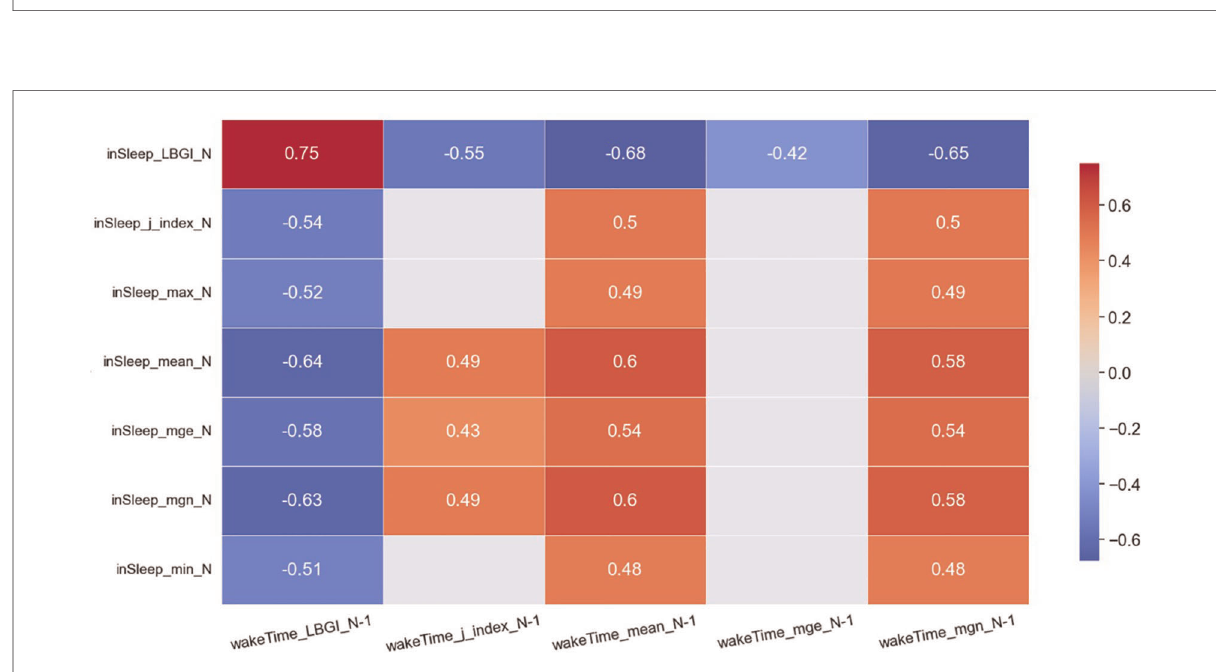
FIGURE 1 Boxplots of glycemic variability metrics (ns: p >0.5; *: 0.01< p ≤ 0.05; **: 0.001< p ≤ 0.01; ***: 0.0001< p ≤ 0.001; ****: p ≤ 0.0001; HBGI was scaled up 100 times).